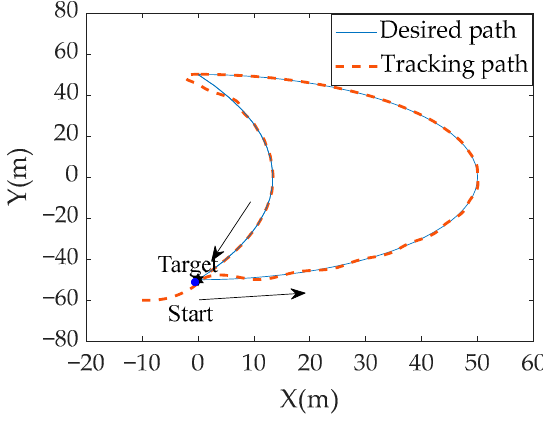
Figure 14. Tracking results for the half-moon shape.